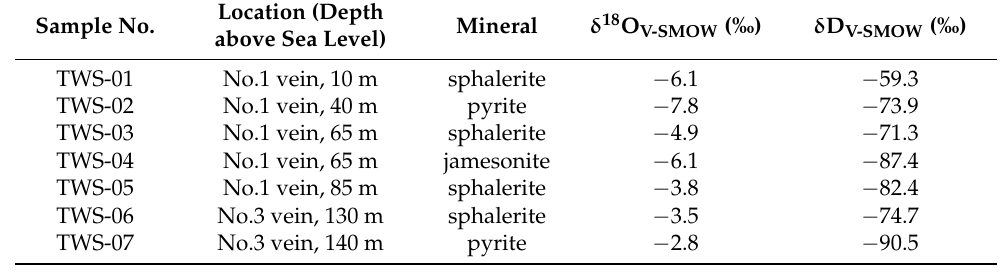
Table 2. Hydrogen and oxygen isotopic compositions of fluid inclusions from second-stage mineral- ization sulfide in the Beixiang deposit.